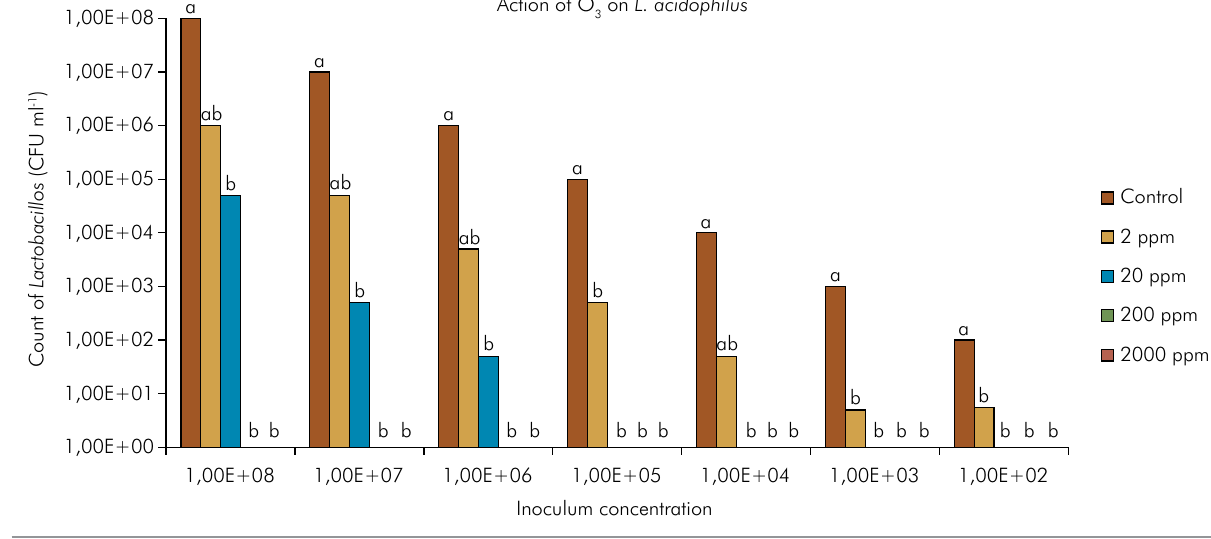
Figure 2. Inhibition of L. acidophilus growth in logarithmic scale (log lower case letters (for comparasions between O